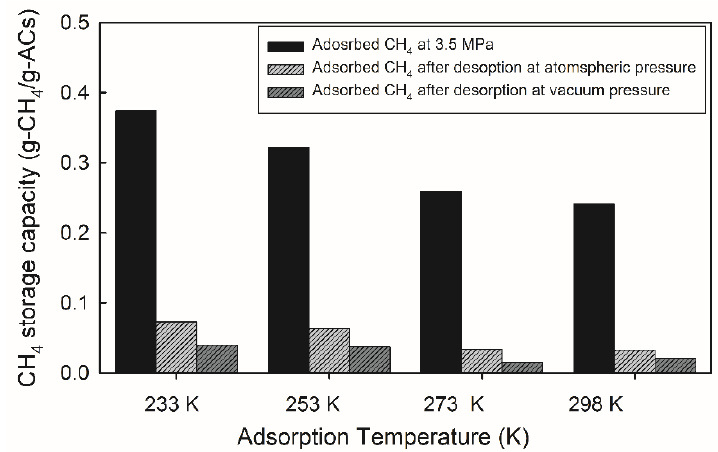
Figure 5. Methane storage and residual capacity as a function of adsorption/desorption temperature for AC-WA. All adsorption experiments were performed at 3.5 MPa and with 12.0 g of AC.